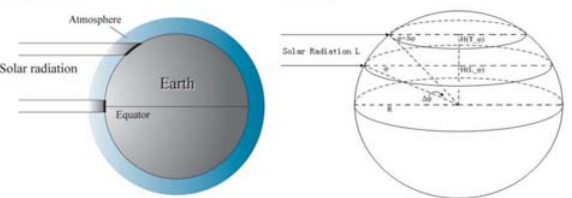
Figure 3. The relationship between solar radiation and solar radiation angle